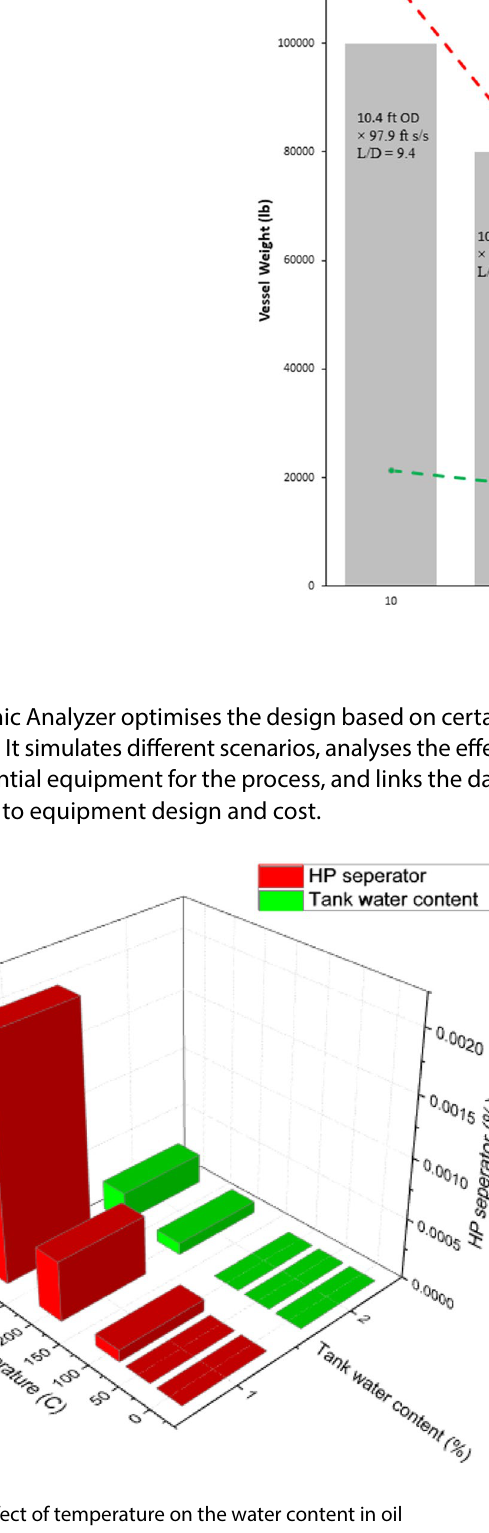
Fig. 7 Effect of viscosity con- cerning temperature